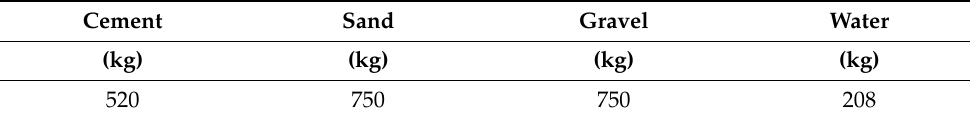
Table 3. Composition of a normalized Ecuadorian concrete.